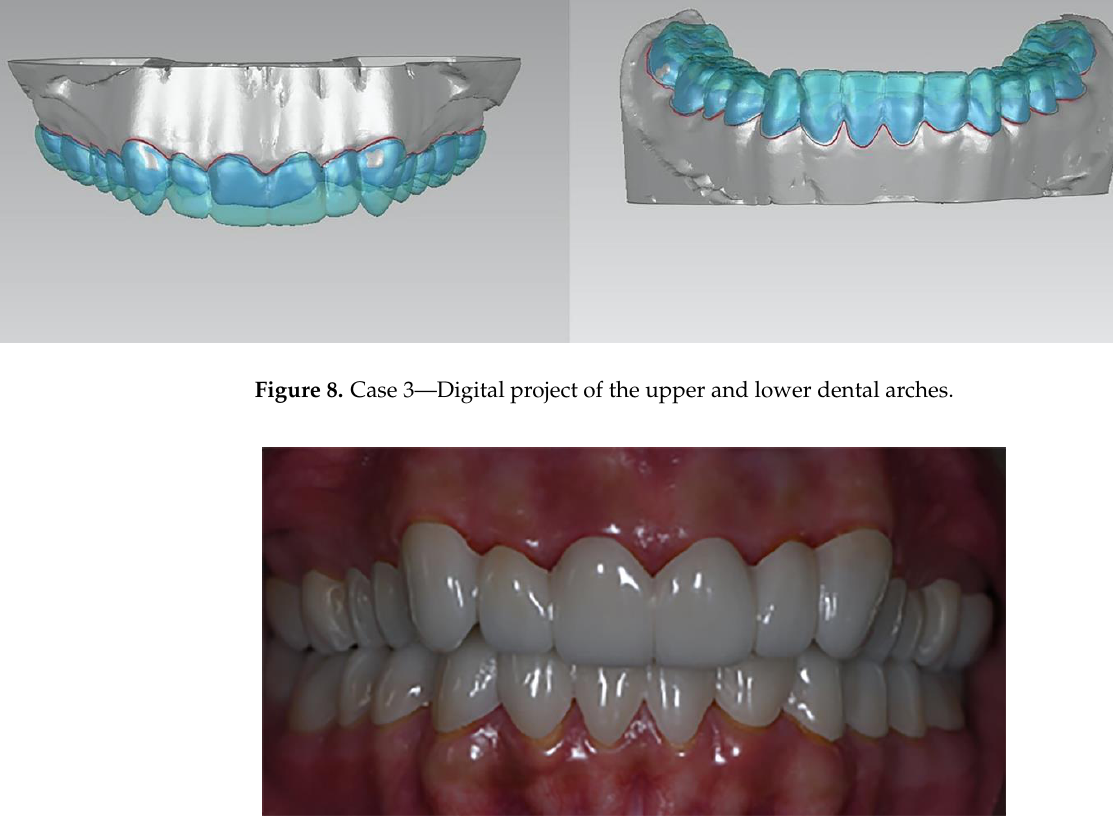
Figure 9. Case 3—DEFS are employed as transitional prosthesis.